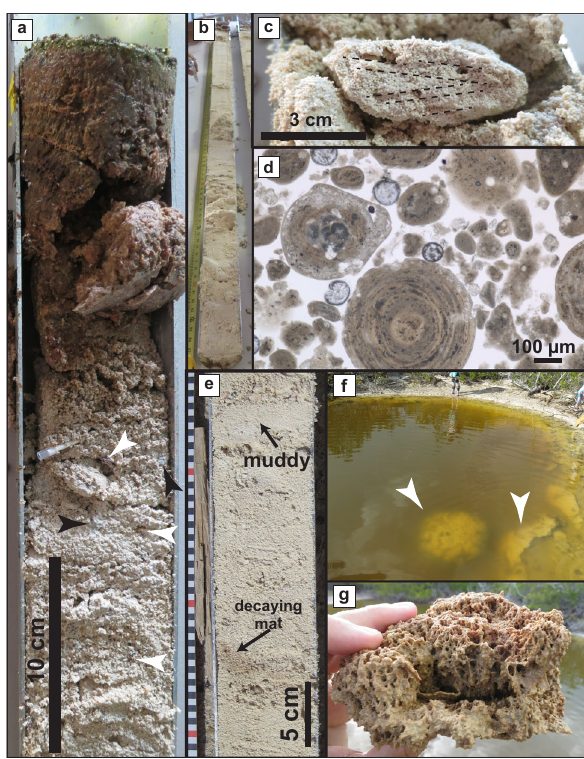
Fig. 2 Sediments associated with microbial mats and crusts. a Top of core VC-03 with polygonal microbial mat overlying ooid-skeletal sand with cerithid gastropods (black arrows) and bivalve fragments (white arrows). b VC-03 consists of ooid-skeletal sand throughout its 223 cm length. c Nodule in a partially indurated interval of core VC-03 at 178 cm preserving small burrows and ripple cross-lamination. d Plane-polarized light photomicrograph showing dissolution features in ooid- Halimeda sand in VC-03 at 150 cm. e Laminated organic material interpreted as a decaying mat in VC-05 at 60 cm, and a thin, mud-rich interval at 42 cm. f Calcifying mats (arrows) along the rim of the hypersaline pond. Researchers for scale. g Mineralization of mangrove leaves and fi laments in the calci fi ed mats rimming the